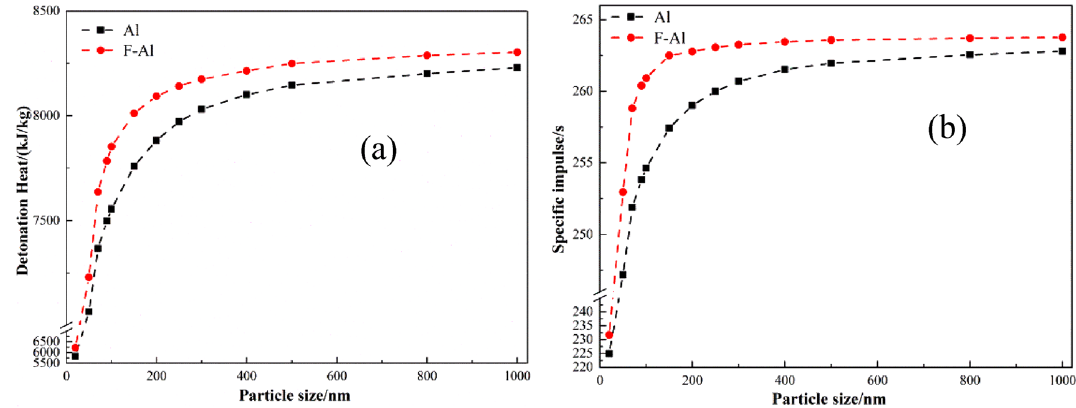
Figure 6. Calculation results of detonation heat and specific impulse of F2311@Al and ordinary Al: ( a ) detonation heat; ( b ) the specific